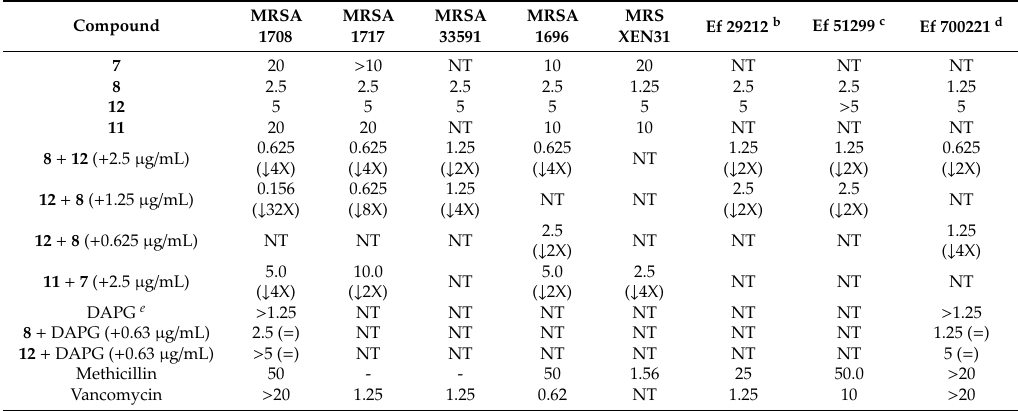
Table 5. Combination study (MIC in µ g / mL) a of compounds 7 , 8, 11 , and 12 by Checkerboard assay against MRSA and